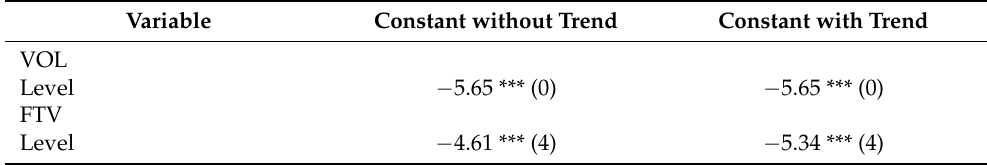
Table 3. Results of ADF unit root tests.